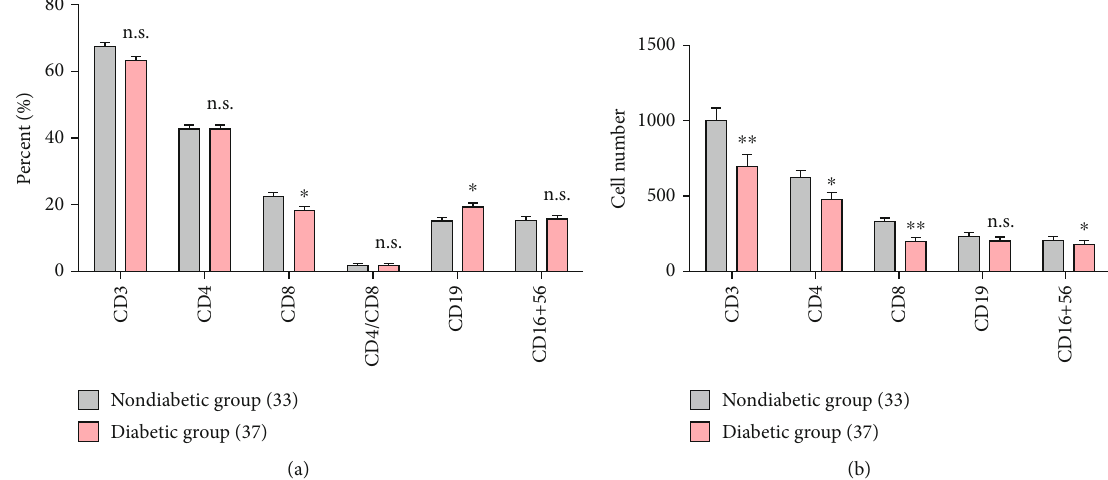
Figure 2: Comparisons of proportions and cell counts of lymphocyte subpopulations between COVID-19 patients with and without diabetes. Note: n.s.: p > 0 : 05 ; ∗ p < 0 : 05 ; ∗∗ p < 0 : 01